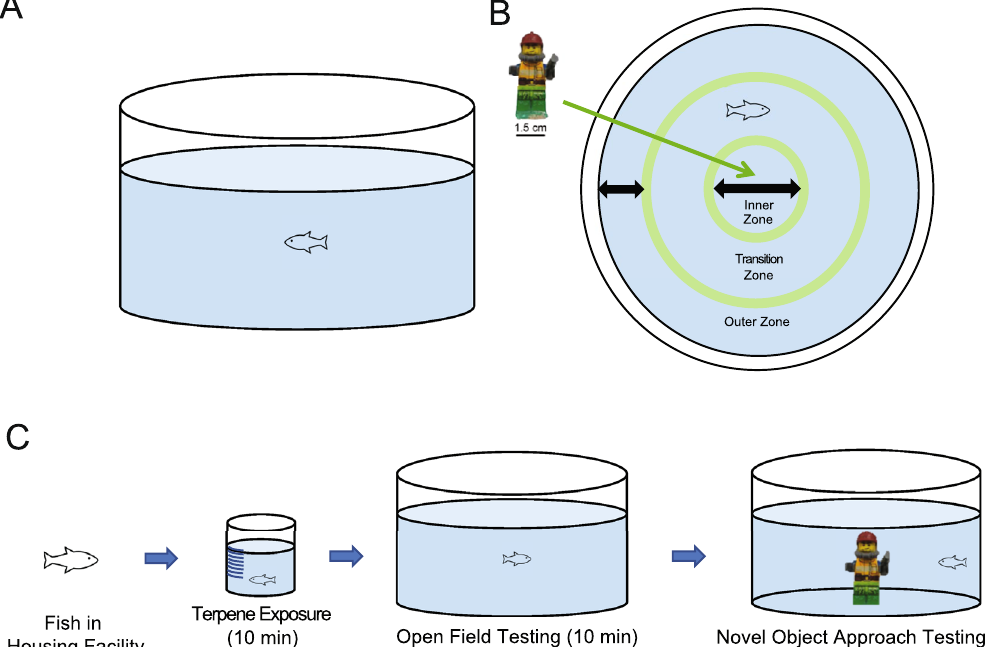
Figure 1. Testing Apparatus. ( A ) The open field testing arena consisted of a white plastic cylinder (26.0 cm in diameter) filled to a water depth of 5.0 cm. ( B ) For the novel object approach test, a multicoloured Lego figurine with a height of 4.25 cm was affixed to the center of the open field arena using a ′ 1 × 2 ′ Lego brick. The test arena was partitioned into three zones in EthoVision XT motion tracking software (inner, transition, and outer zones). ( C ) Diagram of experimental procedure: Individual fish were netted from the housing facility into a dosing beaker for 10-min of terpene exposure, then transferred to the open field arena. After a 10-min trial in the open field test, a Lego figurine was placed into the center of the arena for the 10-min novel object approach test